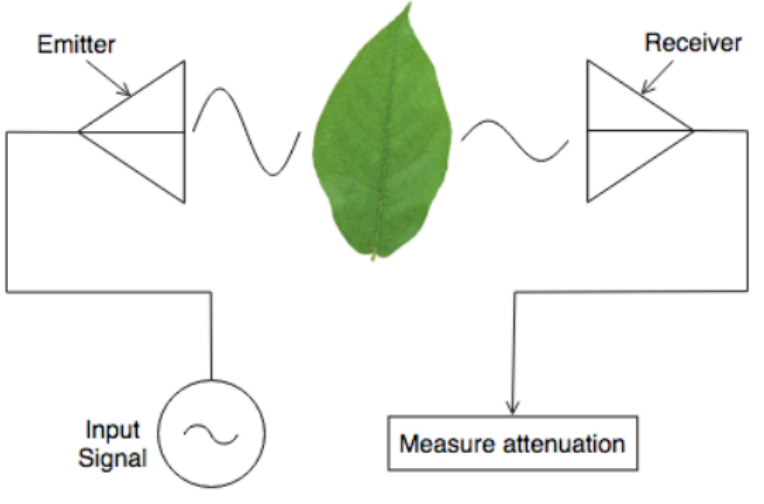
Figure 1. Overview of validated approach